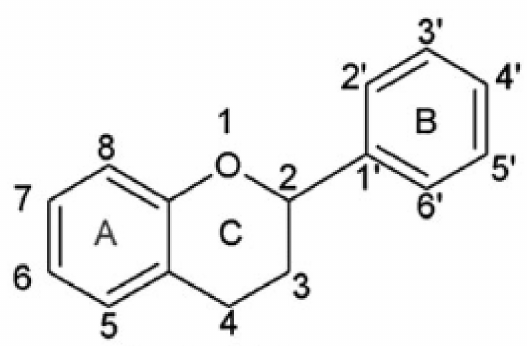
Figure 2. Skeleton of the initial structure of flavonoids.